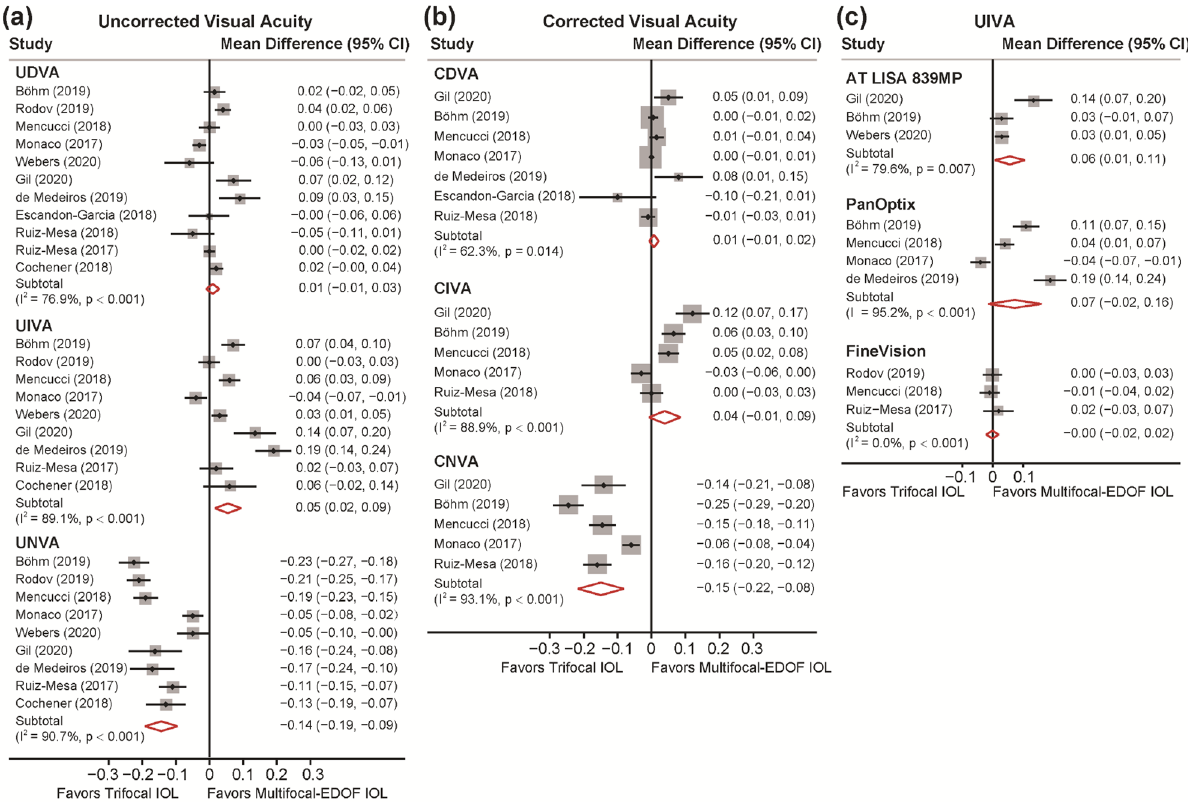
Figure 2. Visual acuities (VAs) in logMAR comparing trifocal and the hybrid multifocal-extended depth of focus (EDOF)intraocular lens (IOL). ( a ) Forest plot displaying mean difference (MD) of uncorrected VA of far, intermediate and near distance. ( b ) Forest plot displaying MD of corrected VA of far, intermediate and near distance. ( c ) Forest plot displaying MD of uncorrected intermediate VA comparing three types of trifocal IOLs and the hybrid multifocal-EDOF IOL.